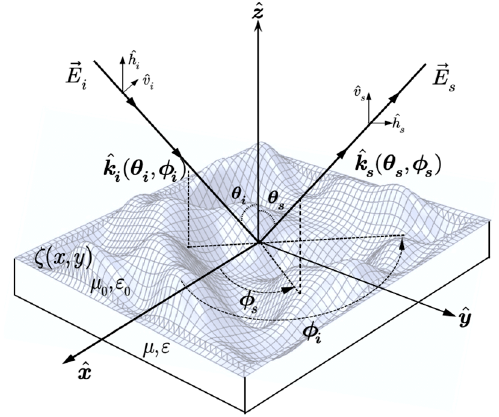
Figure 1. Geometry of wave scattering from a rough surface ζ ( x , y ) .